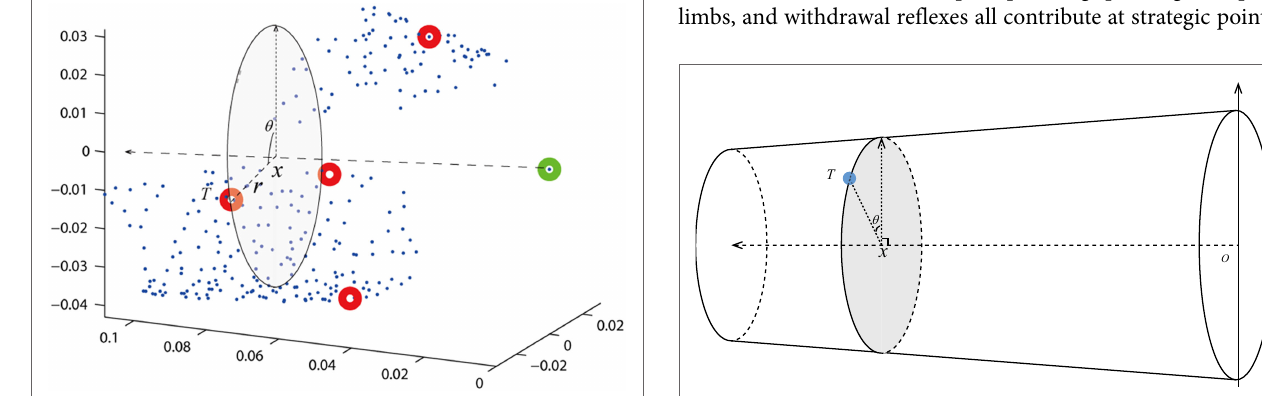
FIGURE 3 | An example of 3-dimensional generic robotic skin model: the forearm skin of iCub .